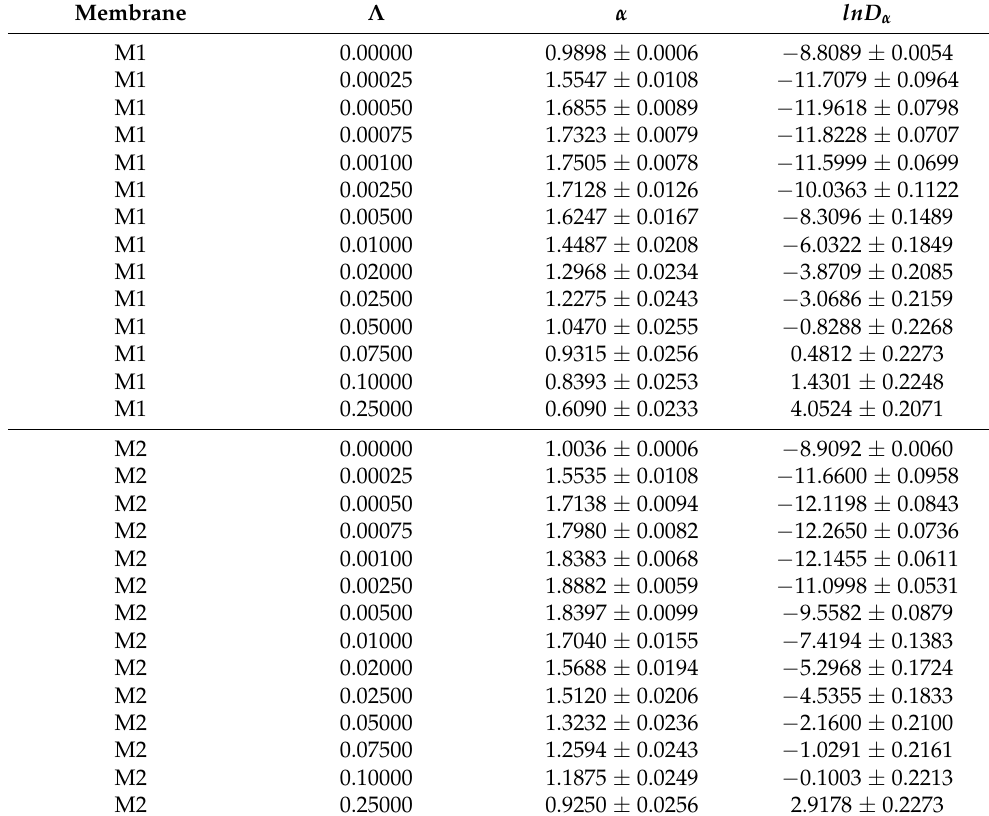
Table A3. Transport properties of artificial membranes with different structural parameters: M1